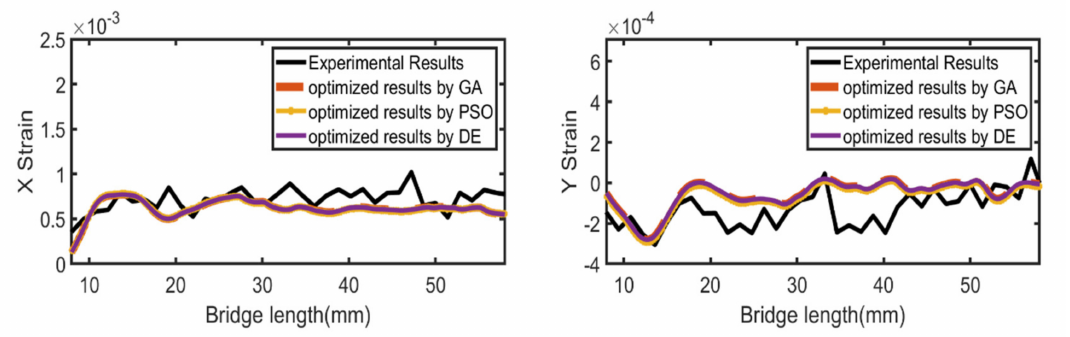
Figure 20. Comparison of simulation results from DNN model using the optimized parameters obtained by GA, PSO, and DE.